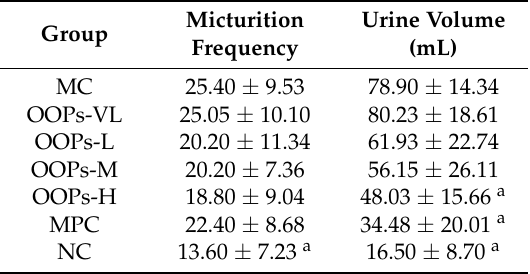
Table 7. Effect of OOPs treatment on the micturition frequency and urine volume.